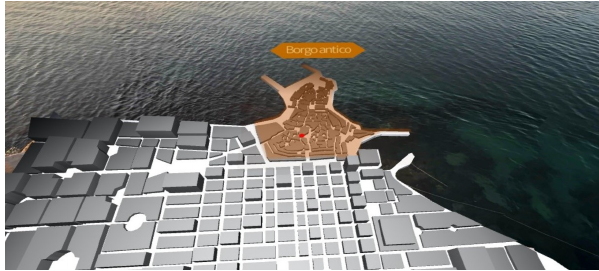
Figure 2. Opening scene of the tour.